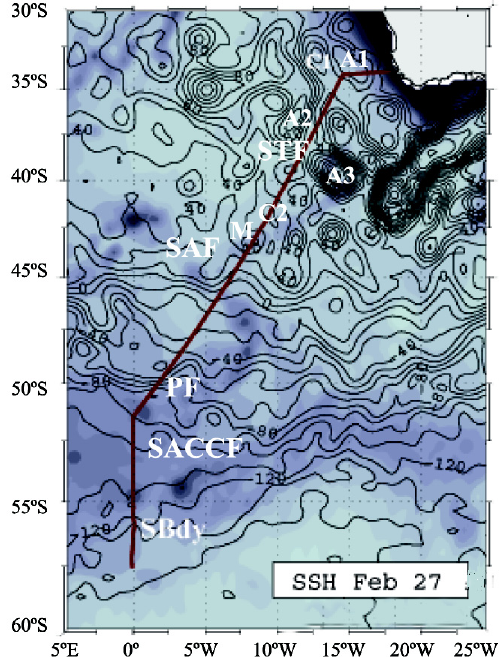
814 Fig. 1. Map showing the cruise track and sea surface height (SSH) for the southwest Atlantic sector of the Southern Ocean during the BONUS GoodHope 2008 cruise. The track is plotted over an al- timetry image for 27 February and the fronts are identified: STF (Subtropical Front), SAF (Subantarctic Front), PF (Polar Front), SACCF (Southern ACC Front) and SBdy (Southern Boundary). Cy- clonic ( C i ) and anticyclonic ( A i and M) Agulhas rings are also